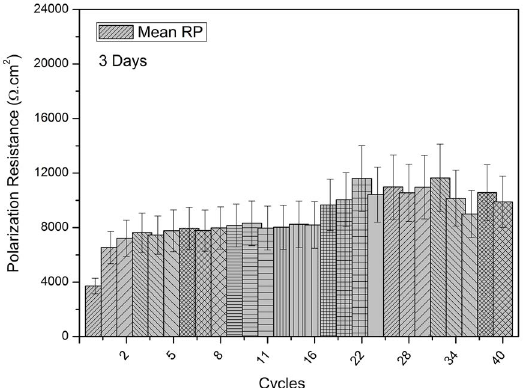
column graphs for 28 days. Figure 10. R p